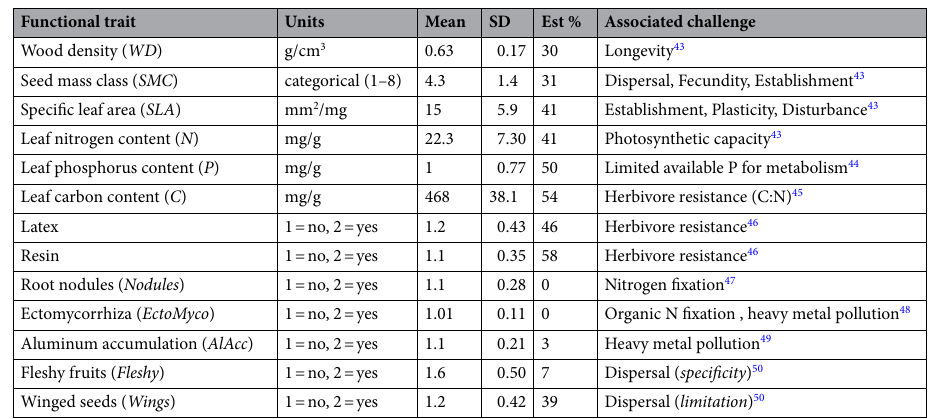
Table 1. Overview of used functional traits. Mean and standard deviation (SD) are calculated after predictive mean matching (percentage of estimated values is given by Est (%)). Associated challenge indicates different aspects of life history and selective environment related to specific functional traits, sources are given in the footnote. For specific methodology of measurement protocols and calculation for each trait we refer to the original sources of the data (see main